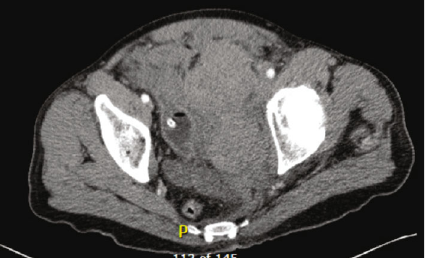
Figure 1: Initial CT abdomen and pelvis in ED (axial): 16 hours postop with large pelvic